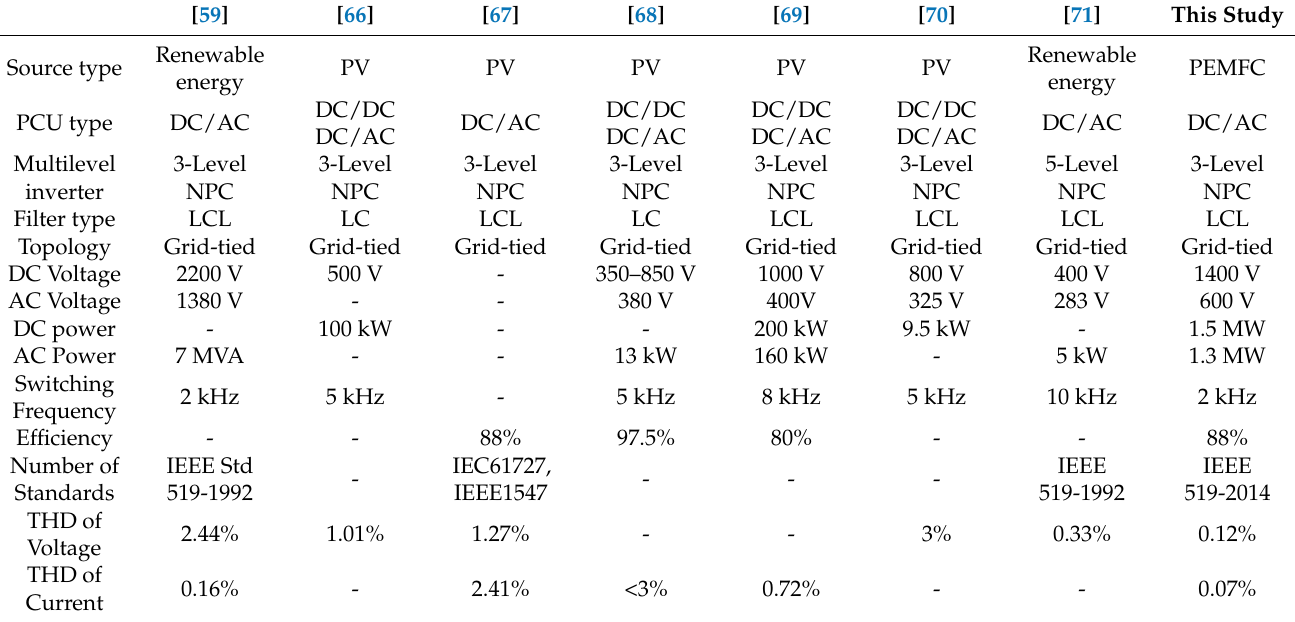
Table 7. Inverter control